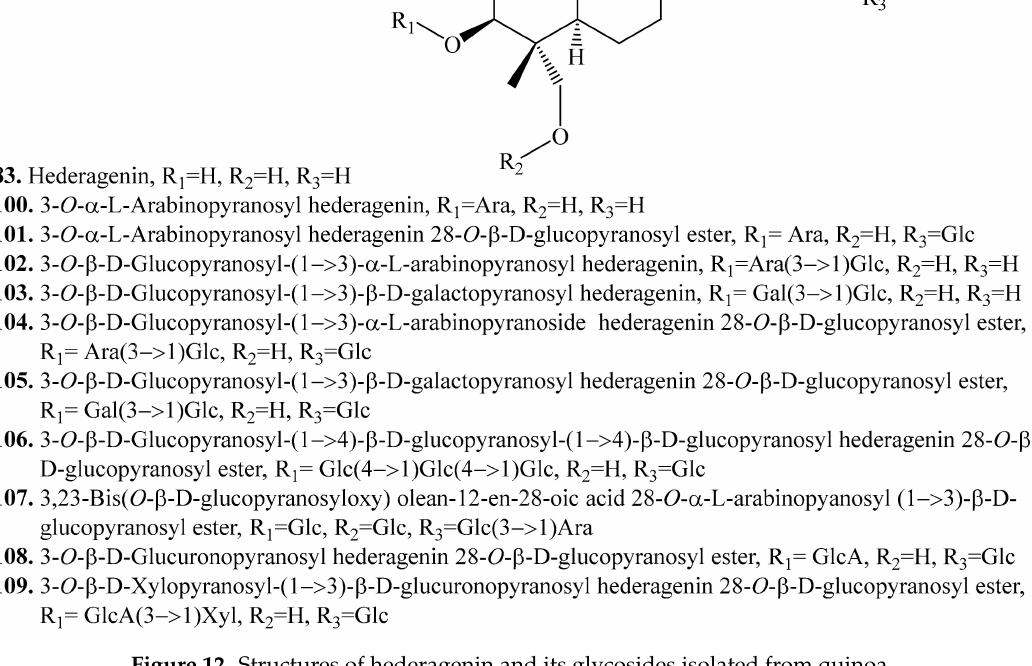
Figure 12. Structures of hederagenin and its glycosides isolated from quinoa.